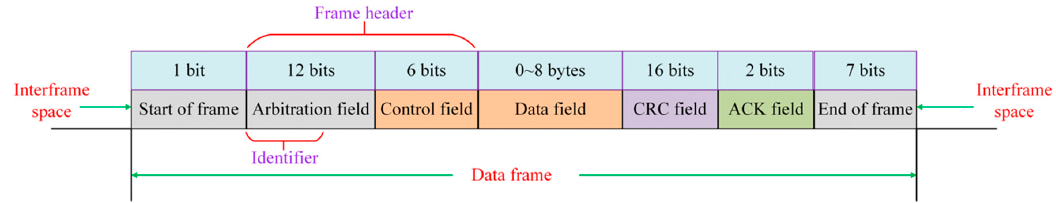
Figure 3. The syntax structure of a standard CAN packet. CRC = cyclic redundancy check, ACK = Acknowledgement Character.